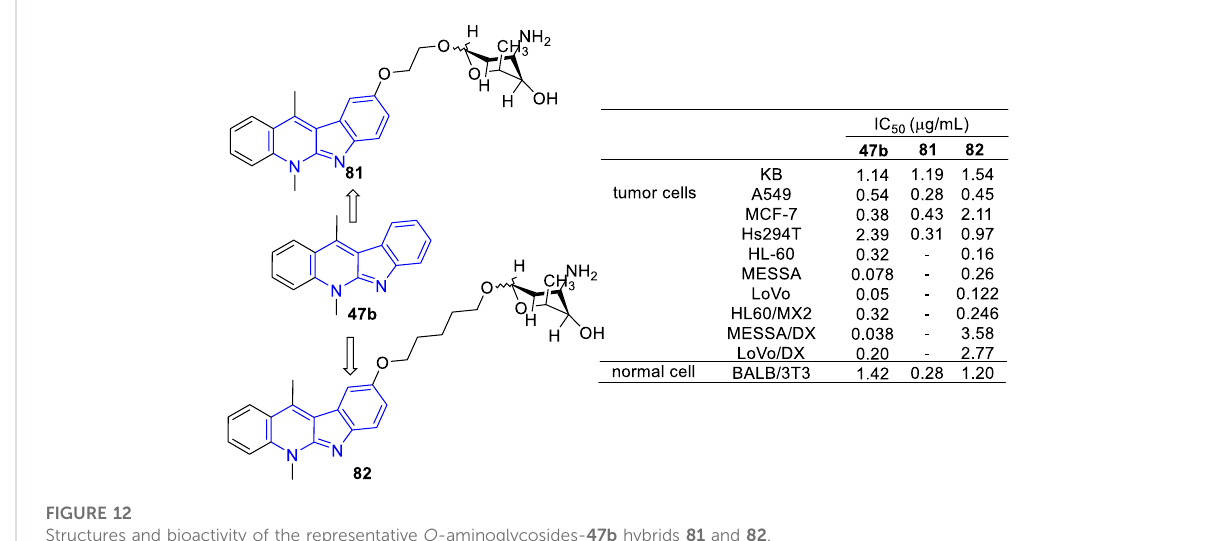
FIGURE 12 Structures and bioactivity of the representative O- aminoglycosides- 47b hybrids 81 and 82 .